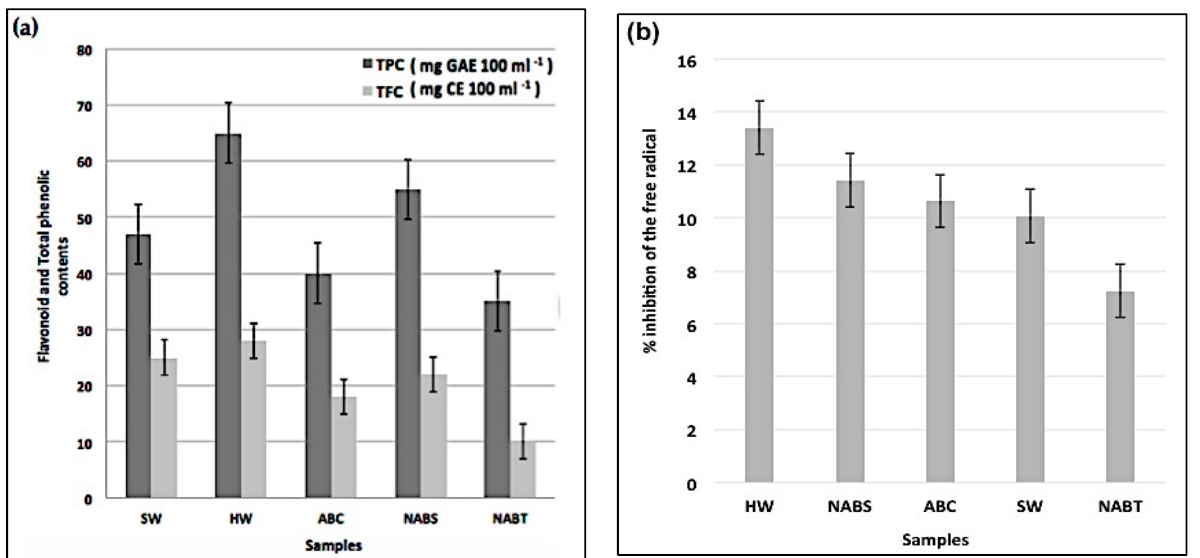
Figure 6. Flavonoid, total Phenolic Contents ( a ) and percentage inhibition of free radical scavenging activity ( b ) of the analyzed samples.